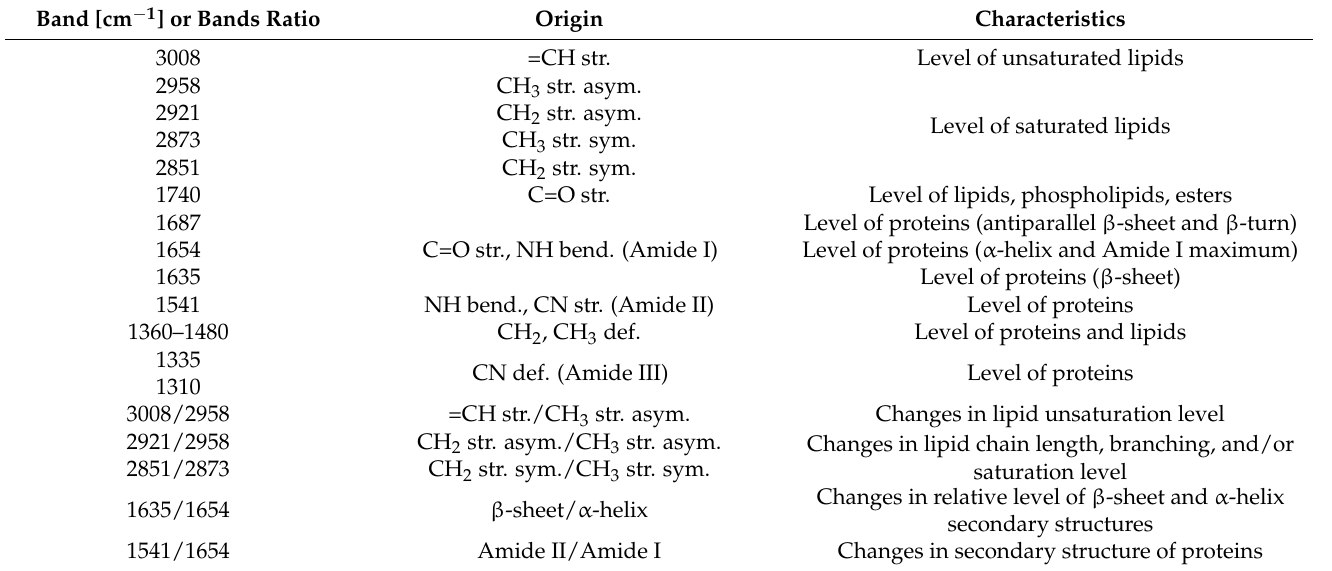
Table 1. Characterization of IR bands and band ratios analyzed in the ATR-FTIR study